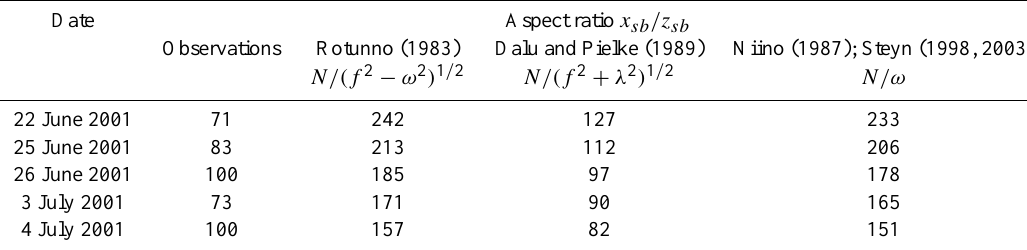
Table 4. Measured and predicted values of the aspect ratio for the documented sea breeze events. N is the Brunt-V¨ais¨al¨a frequency, f = 1 . 01 × 10 − 4 s − 1 is the Coriolis parameter at 44 ◦ N and ω = 7 . 27 × 10 − 5 s − 1 is the diurnal frequency. The values of N are obtained from the 12:00 UTC radiosounding launched from Nˆımes (NIM in Fig. 1) and are 1.7 × 10 − 2 s − 1 on 22 June 2001, 1.5 × 10 − 2 s − 1 on 25 June 2001, 1.3 × 10 − 2 s − 1 on 26 June 2001, 1.2 × 10 − 2 s − 1 on 3 July 2001, 1.1 × 10 − 2 s − 1 on 4 July 2001. λ − 1 is a damping time due to friction and λ is set to 1 . 2 ω in Dalu and Pielke